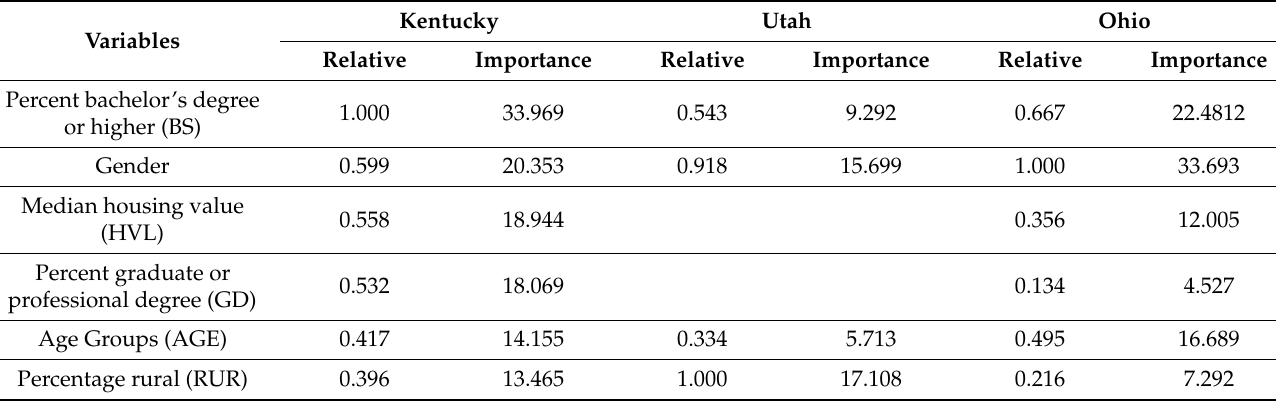
Table A2. List of ACS Variables with High